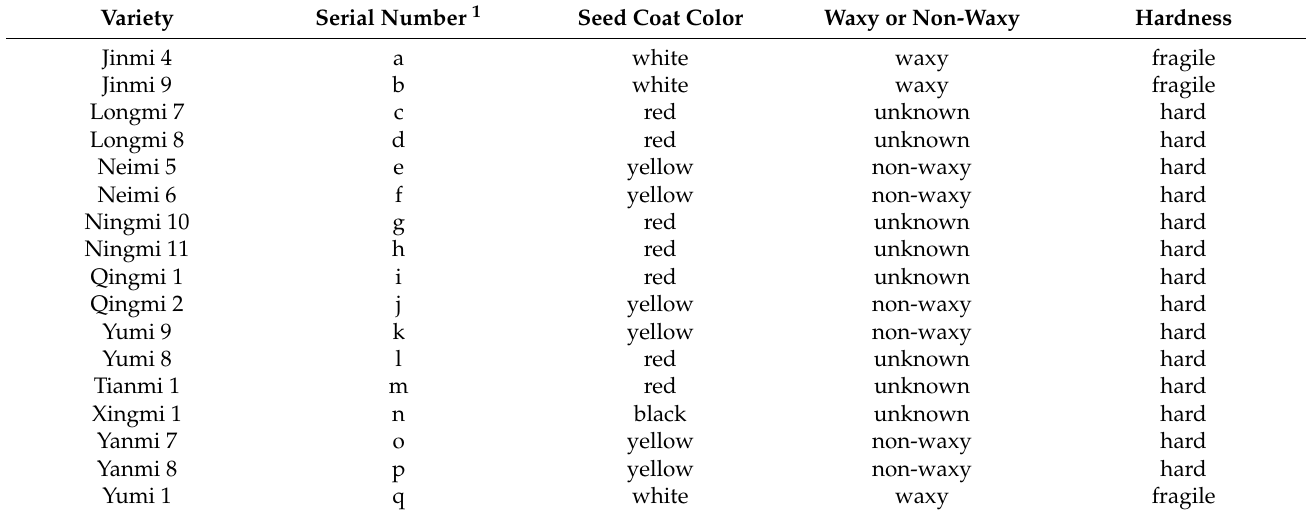
Table 5. Seed characteristics of the 17 broomcorn millet populations considered in this study.